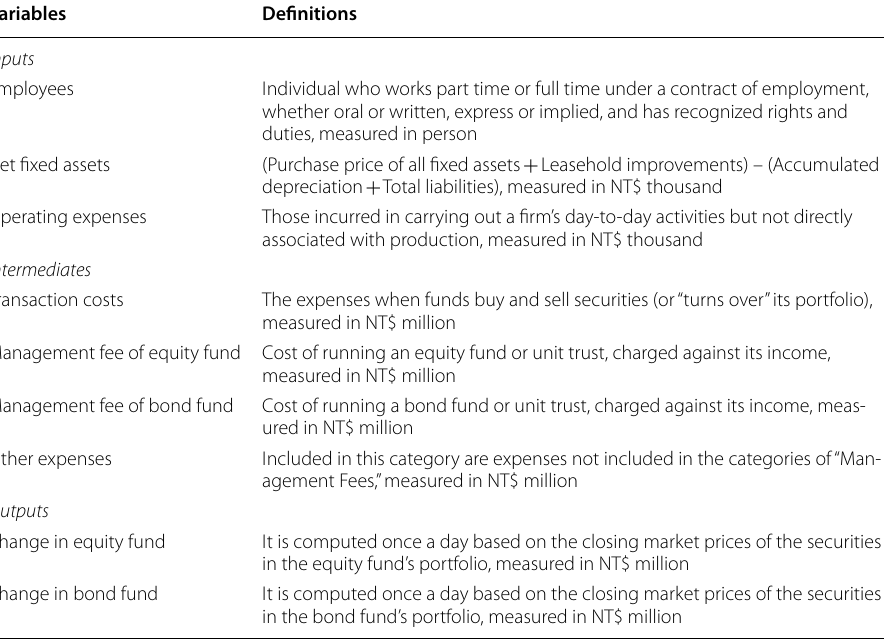
Table 1 Variables